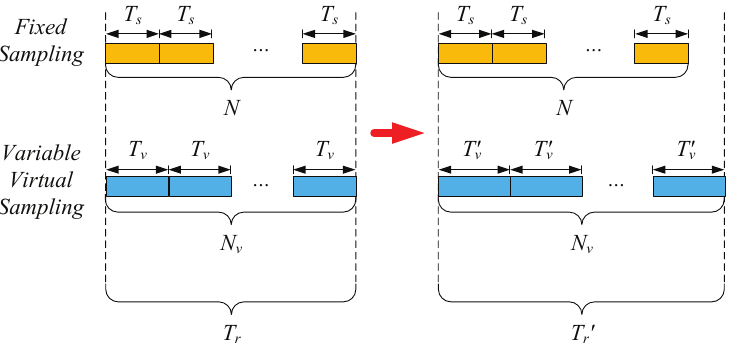
Figure 3. The schematic diagram of variable virtual sampling.